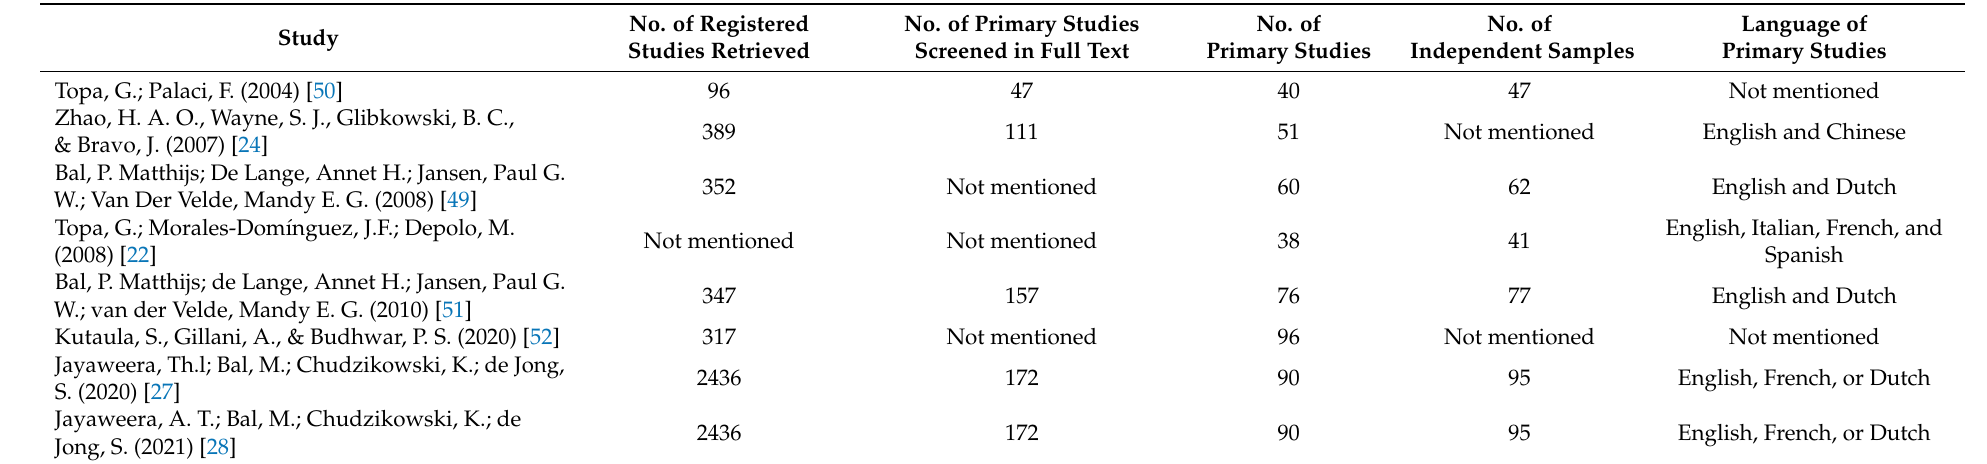
Table 2. Information about the process of retrieving the primary studies, publication search, and other study characteristics.